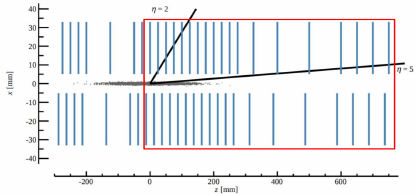
Figure 4. Layout of the upgraded VELO. The detector consists of two retractable halves, each housing an array of 26 silicon pixel detector modules. The red rectangle indicates the modules of interest for forward-track